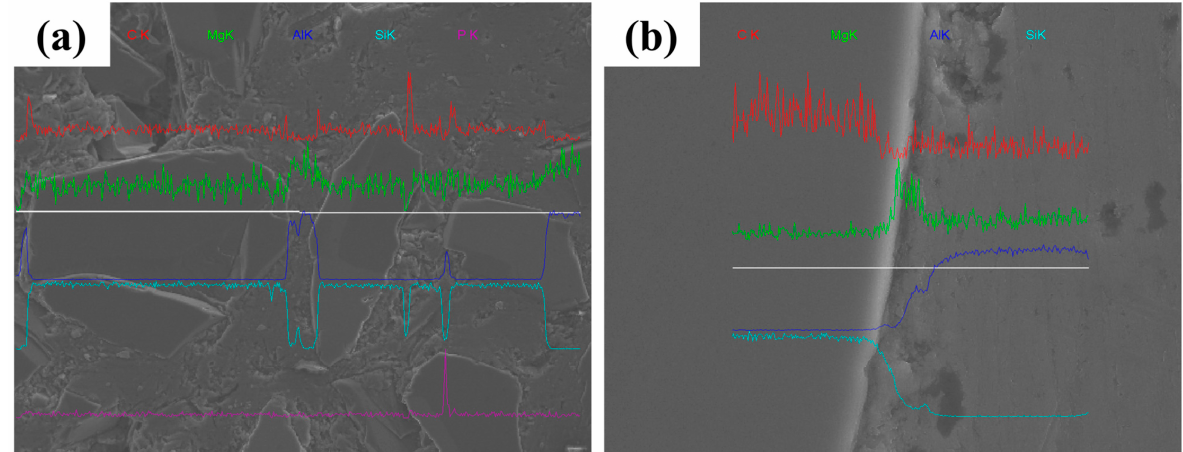
Figure 9. EDS patterns of SiC/Al Composites: ( a ) SiC/Al-7Si-Mg; ( b ) SiC/Al-12Si-Mg.